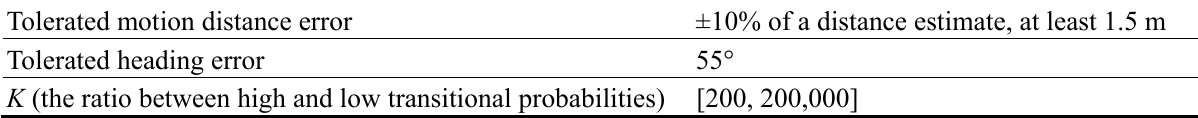
Table 4. The parameter settings used in the HMM